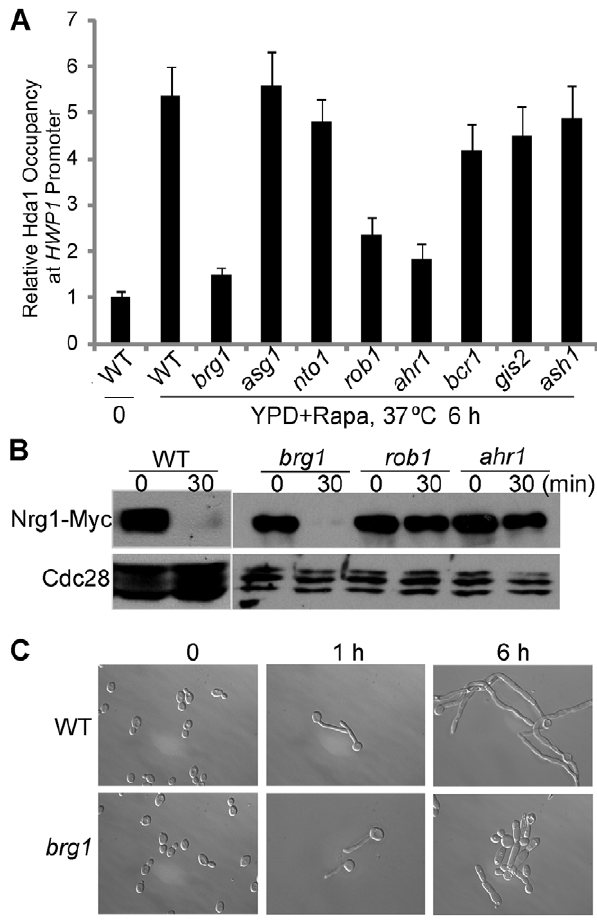
Figure 1. brg1 is the only mutant found to be defective in Hda1 promoter recruitment. (A). ChIP of Hda1-Myc in mutants defective in hyphal elongation. Wild type and indicated mutant cells carrying Hda1- Myc were diluted into YPD + 10 nM rapamycin medium at 37 u C for 6 h. ChIP DNA was quantitated as described [18] by qPCR with primers at the UAS region of HWP1 [30]. The 0 h values of wild type cells were set to be 1.00. The ChIP data show the average of three independent qPCR experiments with error bars representing the SEM. (B) Western analysis of Nrg1-Myc. brg1 , rob1 , and ahr1 mutant cells carrying Nrg1-Myc were diluted into YPD medium at 37 u C for 30 min. (C). Overnight cultures of wild type (SN250) and brg1 mutant were diluted 1:250 fold into YPD medium at 37 u C. 5 nM rapamycin was added after 1 hour to YPD medium. Cells were collected at 0 h, 1 h, and 6 h for cell morphology